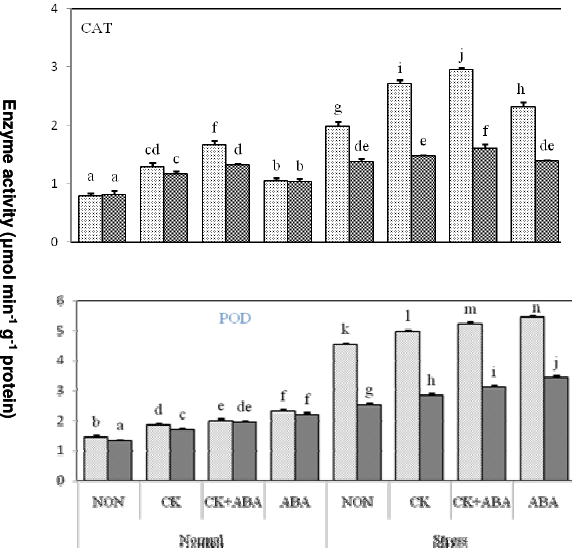
Fig. 5. Effect of hormonal treatments of CK, ABA and CK/ABA on enzyme activity of α -tocopherol content CAT and POX under irrigation and drought condition in flag leaves during grain filling in two wheat cultivars (drought tolerant cv. ‘ Pishgam ’ (white columns) and drought sensitive cv. ‘ MV-17 ’ (black columns). Data are shown as mean ± SD of three